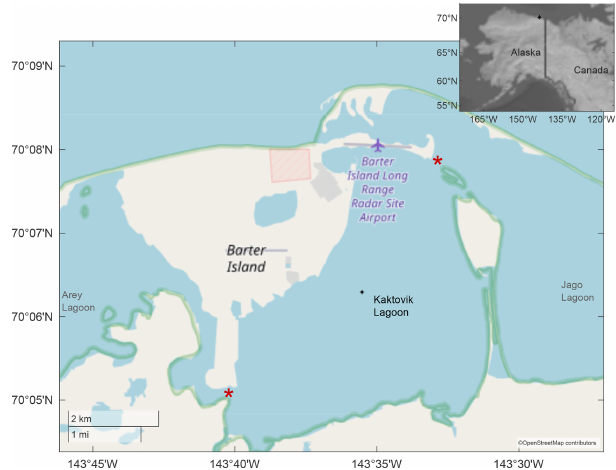
Figure 1. Study site at Kaktovik Lagoon along the Beaufort Sea Coastline. Red stars denote the main exchange pathways between adjacent lagoons and the greater Beaufort Sea. The black star in inset map is the location of Kaktovik